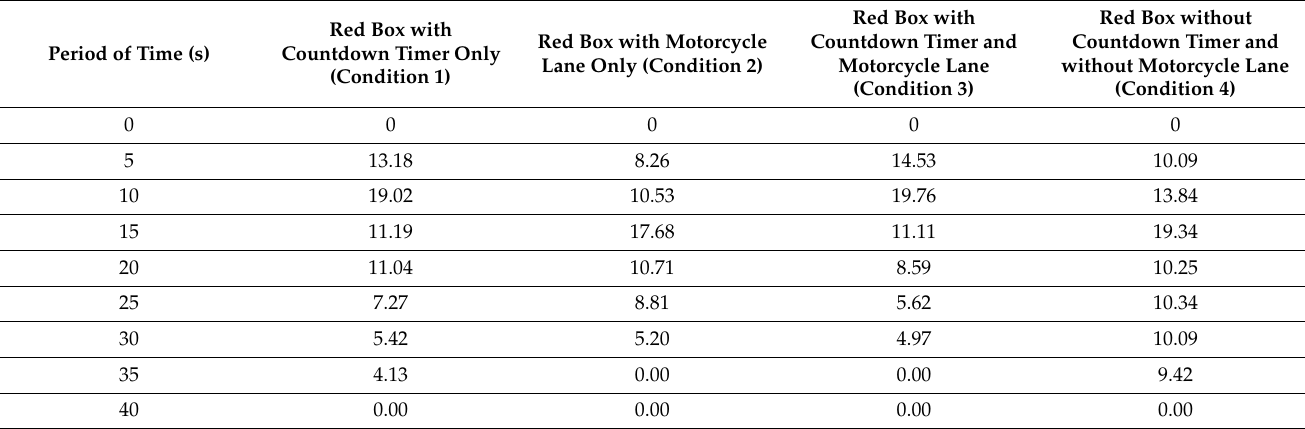
Table 2. Average traffic flow value in 30 green-light